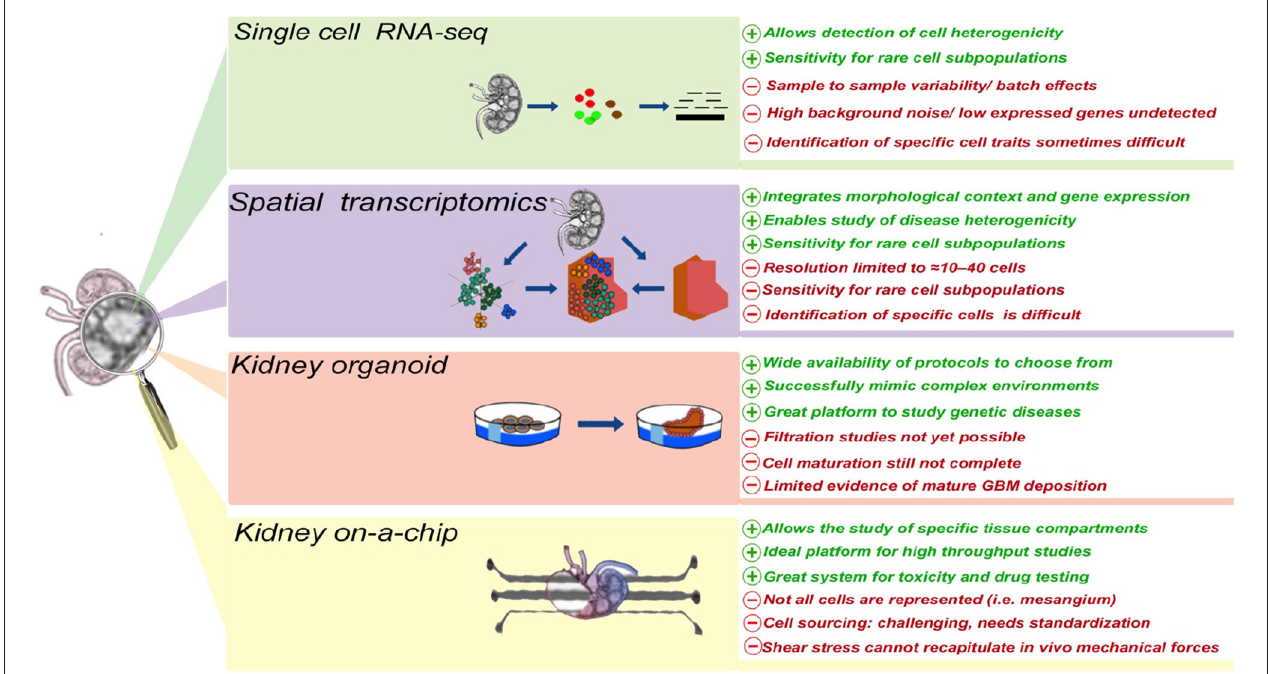
FIGURE 1 | The advantages and disadvantages of different technologies currently applied to study cellular and molecular mechanism(s) of proteinuria.